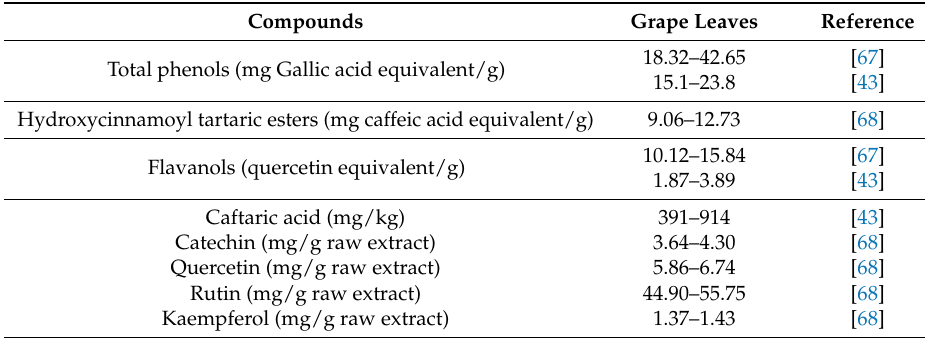
Table 2. Grape leaves’ phenolic